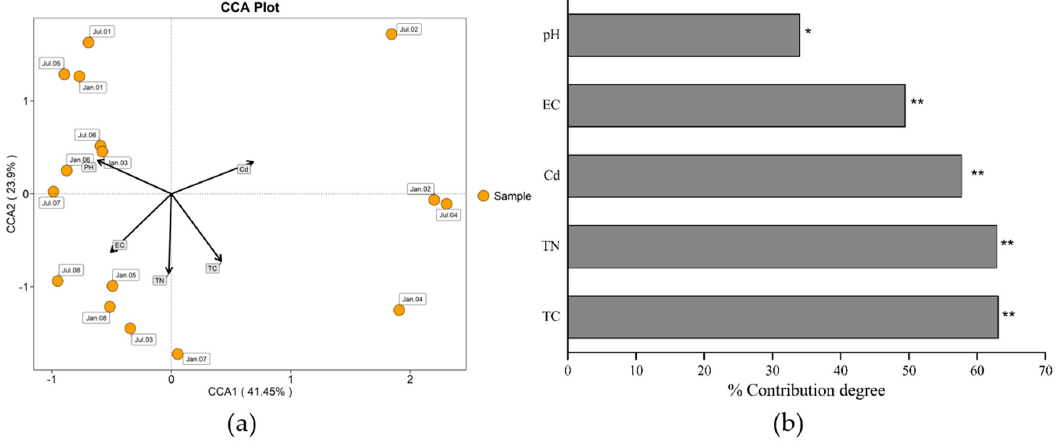
Figure 6. Canonical correlation analysis (CCA) ordination plots for the two dimensions to show the relationship between the bacterial community structure and environmental parameters using a 16S rRNA gene sequence. ( a ) Correlations between environmental variables and CCA axes are represented by the length and angle of arrows (environmental factor vectors). PERMANOVA shows the explanation of single factors in the community structure of bacteria; ( b ) A single asterisk sign “*” next to a bar denotes significance at p < 0.05; A two-asterisk sign “**” next to a bar indicates significance at p < 0.01.